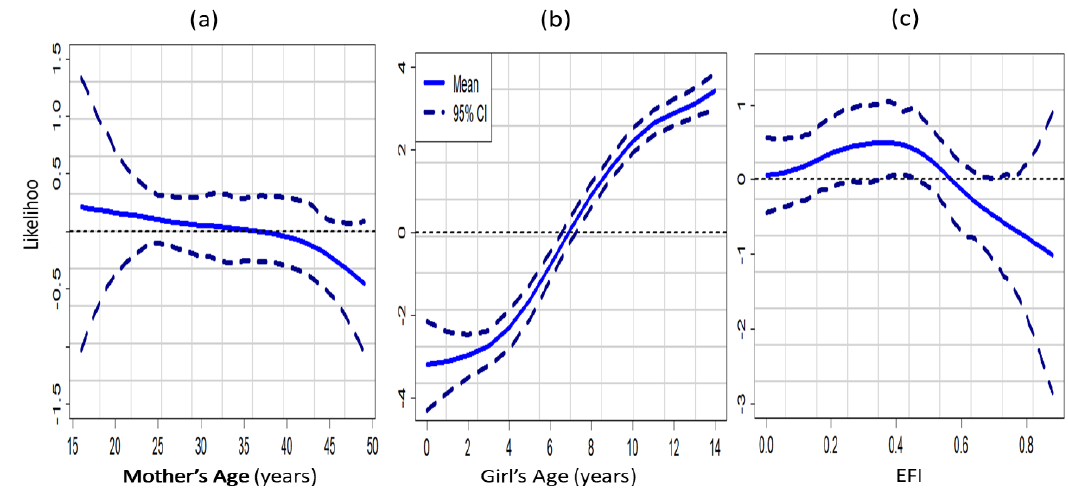
Figure 5. Non-linear e ff ects on a girl’s likelihood of experiencing FGM / C of mother’s age ( a ); girl’s age ( b ) and ethnic fractionalization index (EFI) ( c ). Evidence from the 2014 KDHS Model C.